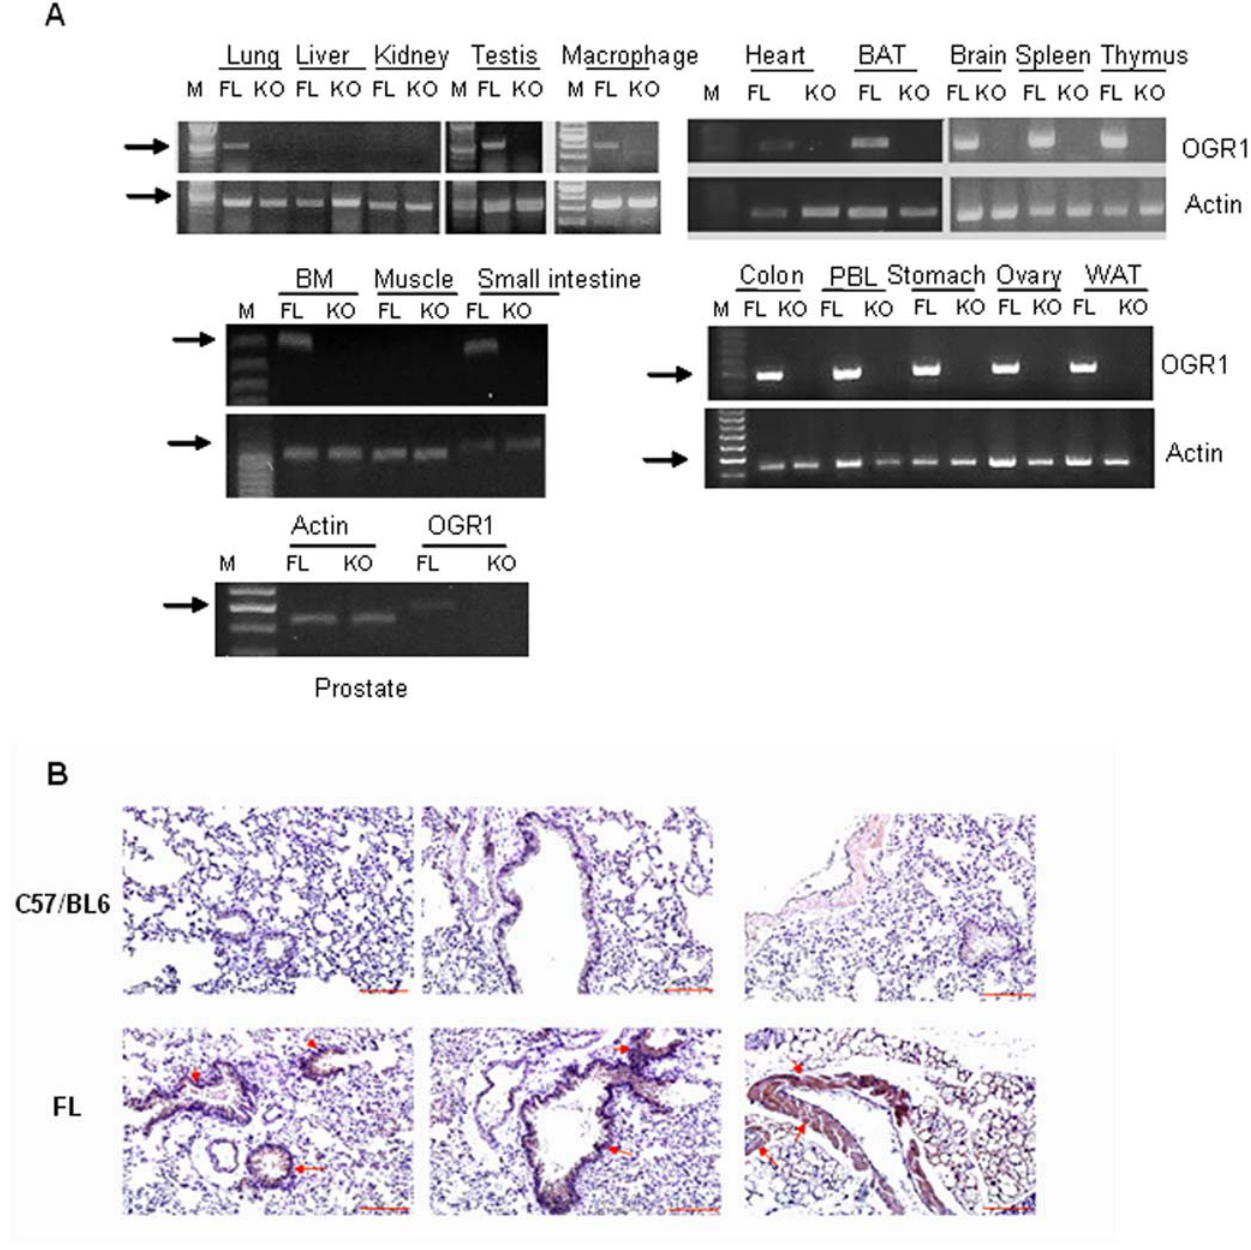
Figure 2. OGR1 expression in mouse tissues and cells. (A) OGR1 expression in various tissues from FL and KO mice detected by RT-PCR. The PCR program was 94 u C, 2 min; 25 cycles for actin and 35 cycles for OGR1 (94 u C, 30 s; 55 u C, 1 min; 72 u C, 1 min); 72 u C, 10 min, except both actin and OGR1 in macrophages were amplified by 30 cycles. BAT, brown adipose tissue; BM, bone marrow; PBL, peripheral blood leucocytes. The arrows indicate DNA ladders with 500 bp. (B) OGR1 distribution in lung tissue from FL and C57/BL6 mice. Anti-FLAG M2 antibody (1:200) was used. Representative positively stained cells are indicated by arrows. Scale bar=100 m m.